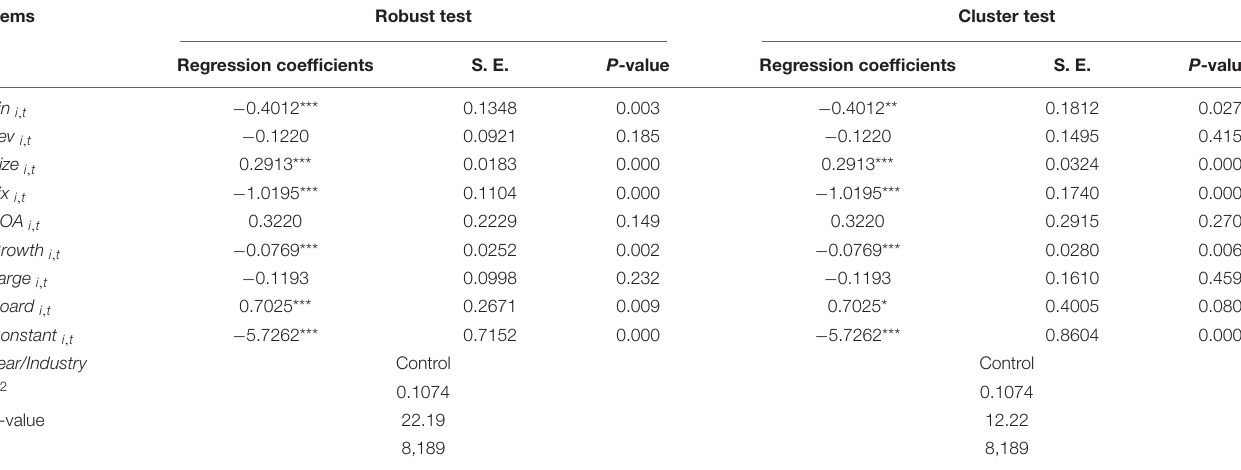
TABLE 5 | Robust test and clustering test.